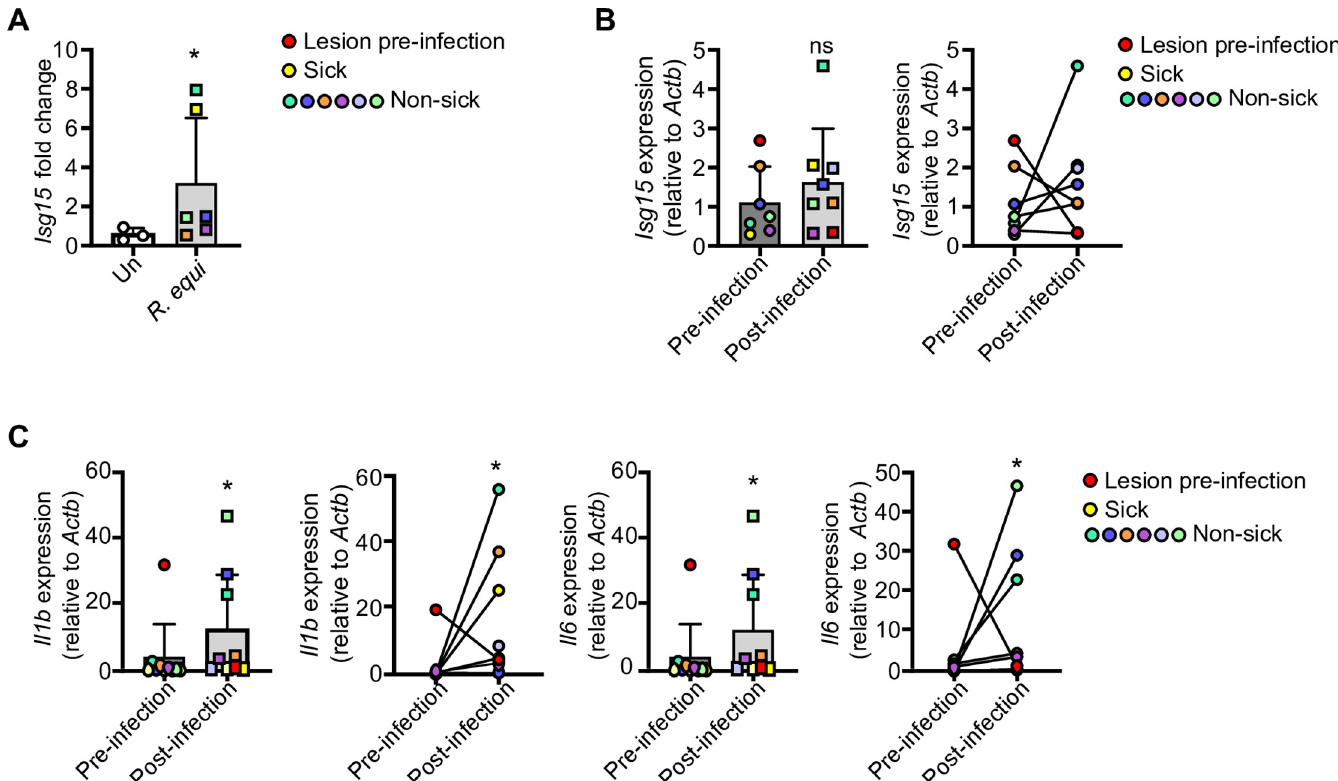
Fig 8. R . equi induces type I IFN response in equine monocytes. (A) RT-qPCR of Isg15 in sham infected and R . equi infected foals at 21d post-infection normalized to baseline Isg15 levels. Each dot represents an individual foal. (B) As in (A) but comparing baseline Isg15 levels to 21d post-infection in infected foals. Red dot indicates foal with lesions prior to experimental infection and yellow dot indicates foal that became clinically ill after infection. (C) As in (B), but for Il1b and Il6 . Horse RT-qPCRs represent > 3 biological replicates ± SD, uninfected n = 3, infected n = 6. For all experiments in this study, statistical significance was determined using Mann Whitney test. � p < 0.05, �� p < 0.01, n.s. = not significant.